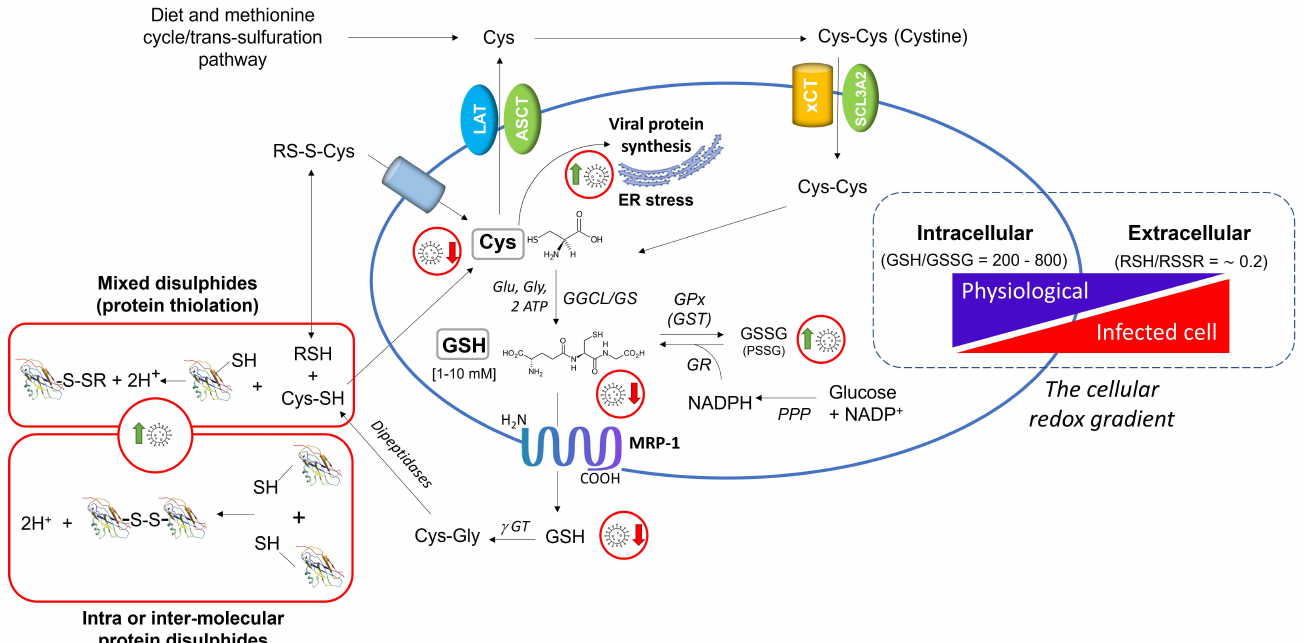
Figure 1. SARS-CoV-2 infection interferes with the bidirectional flux of cellular thiols (cystine-cysteine cycle) and glutathione metabolism. Cells actively control their redox state and the redox homeostasis of the extracellular environment, synthesizing the tripeptide glutathione and maintaining it in its reduced form (GSH). This latter process relies on the glycolytic activity of the Pentose Phosphate Shunt (PPP) that supports reducing equivalents (under the form of the pyridine coenzyme NADPH) to GSH- reductase (GR). The de novo biosynthesis process of glutathione depends on the cellular availability of Cys. Adequate Cys levels are provided through the diet and the trans-sulfuration pathway and reach the cells by means of the cystine-cysteine cycle. This cycle and the efflux mechanisms of cellular thiols maintain GSH, Cys, and the other LMW thiols available in the extracellular milieu for the reaction with protein thiols (left insert) and for the intercellular metabolism of GSH. At the same time, this cycle participates in the homeostatic control of the redox gradient existing between cells and extracellular fluids of tissues (right insert). The viral replication process implies an increased incorporation of cellular Cys in the viral proteins, thus reducing its availability for the biosynthesis of GSH and the redistribution of cellular thiols to the extracellular compartment. Aging conspires with SARS-CoV-2 infection to promote these changes in the metabolism of thiols, which may increase the risk of degenerative complications and severe